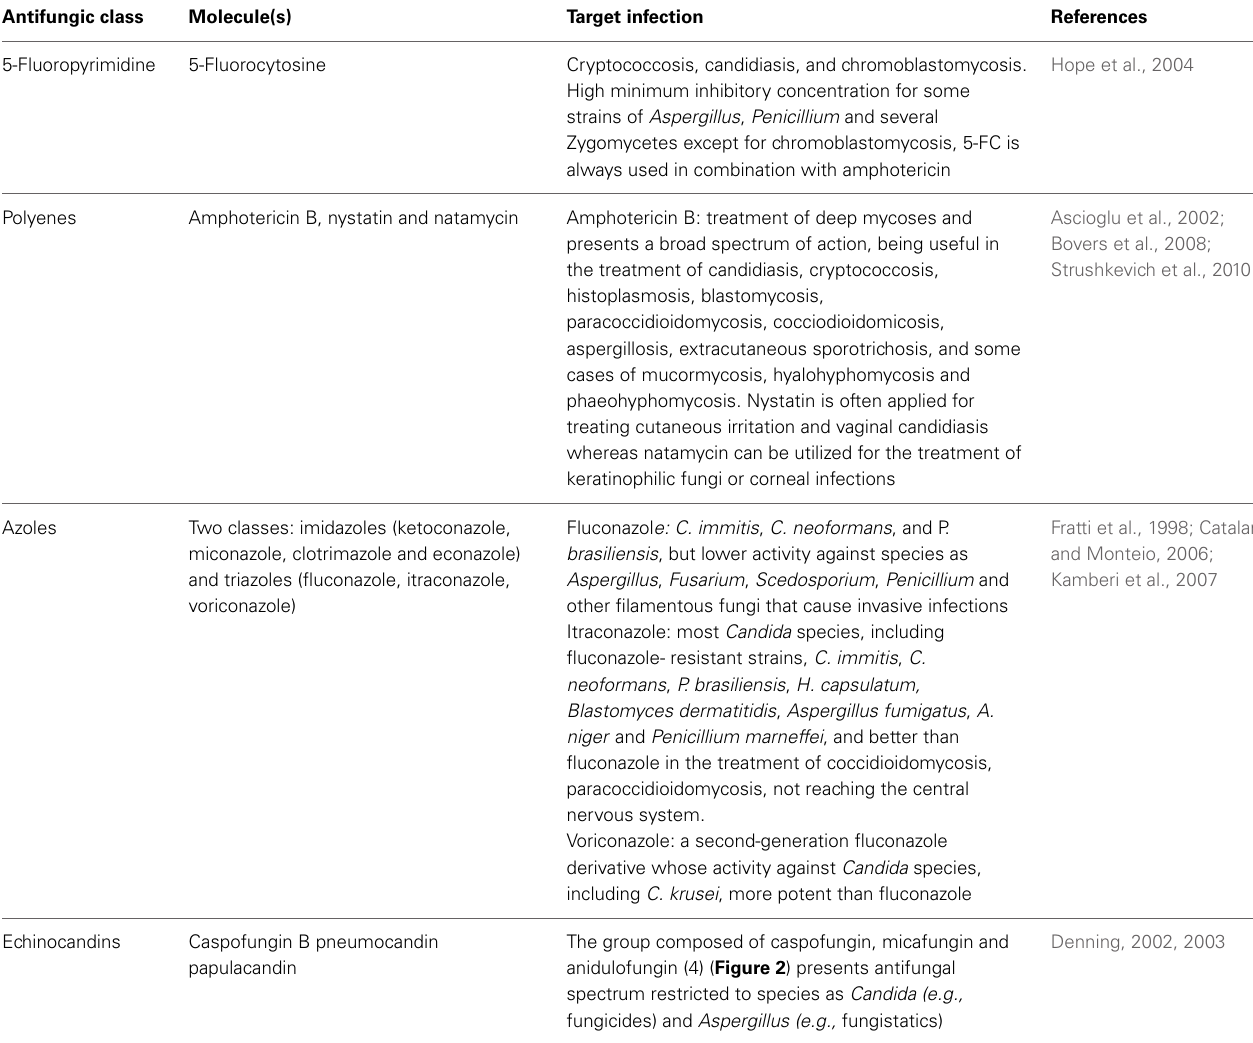
Table 1 | Comparison of the current features of the antifungal agents present in the